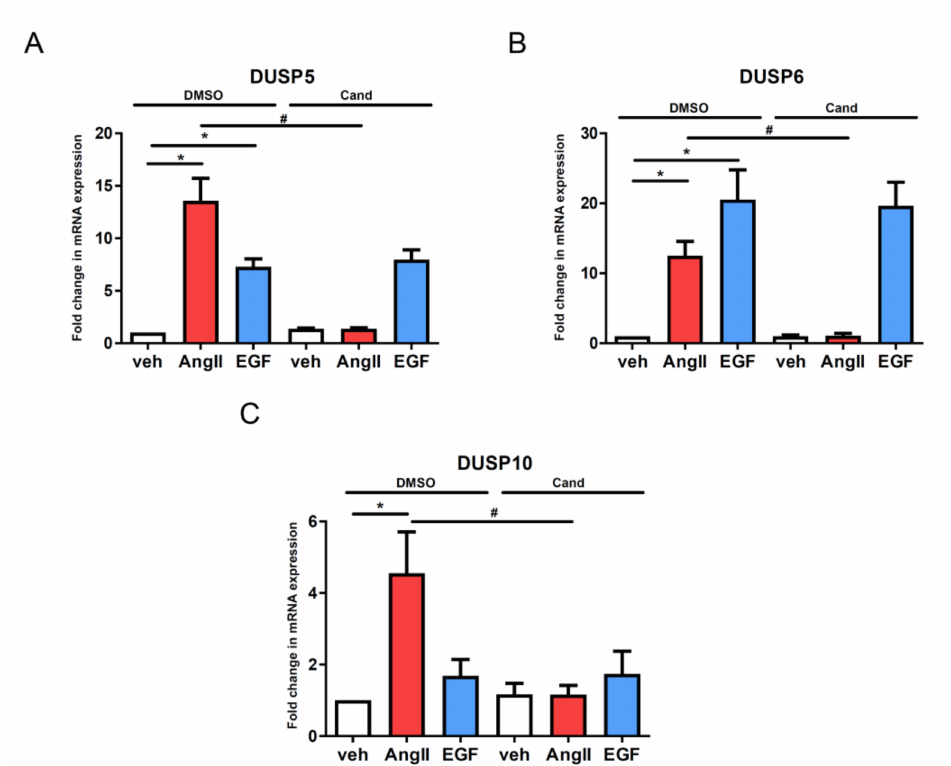
Figure 3. Effect of AT 1 -R antagonist treatment on the agonist-induced gene expression changes of the DUSP isoform in vascular smooth muscle cells. Serum-starved cells were incubated with 10 µ M candesartan (Cand) or DMSO as a control for 30 min, then the cells were exposed to either 100 nM AngII (red columns) or 50 ng/mL EGF (blue columns) or the vehicle (white columns) for 2 h. Standardization was made against the GAPDH housekeeping gene. The mRNA levels of DUSP5 ( A ), DUSP6 ( B ) and DUSP10 ( C ) were normalized to values of DMSO vehicle samples and expressed as fold change. Mean values ± SE are shown. Significance was determined with multiple linear regression. p < 0.05 was considered as statistically significant. *: statistically significant from vehicle stimulation. #: statistically significant from DMSO-pretreated agonist-induced response. The values are from four independent experiments ( n =